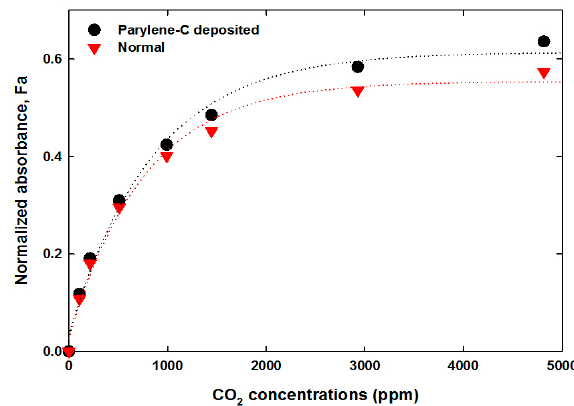
Figure 3. Comparison of normalized absorbance of infrared light as a function of CO 2 concentrations (@ 298